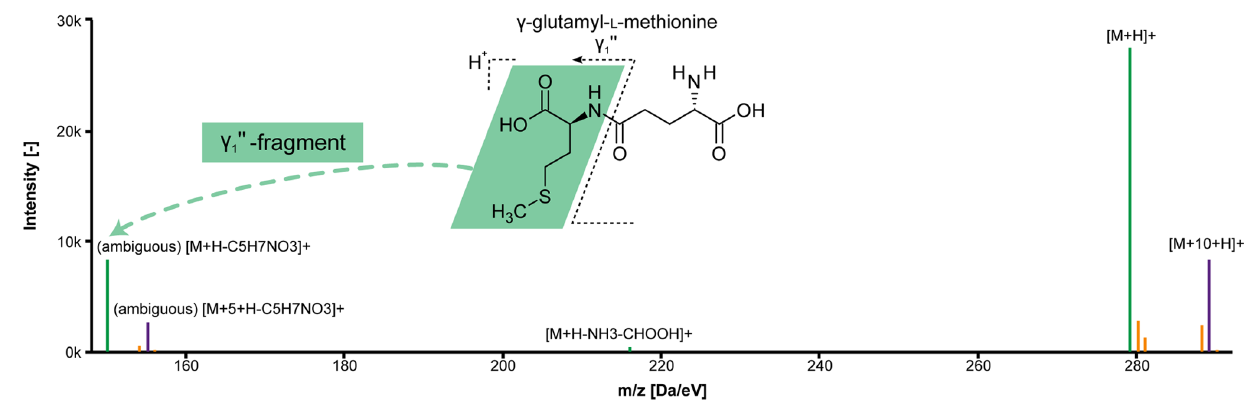
Figure 5. Pseudo spectrum and molecular structure of ( c -)glutamyl-L-methionine. The c 1 ’’-fragment (on the very left) could be annotated thanks to the additional information provided by the 13 C monoisotopic peaks; green: 12 C monoisotopic peaks; magenta: 13 C monoisotopic peaks; blue: associated heteroisotopic peaks; the ‘‘(ambiguous)’’ tag informs the user, that this neutral loss was calculated by mass decomposition and filtered for the correct number of carbon atoms, but still multiple sum formulae might explain the present mass